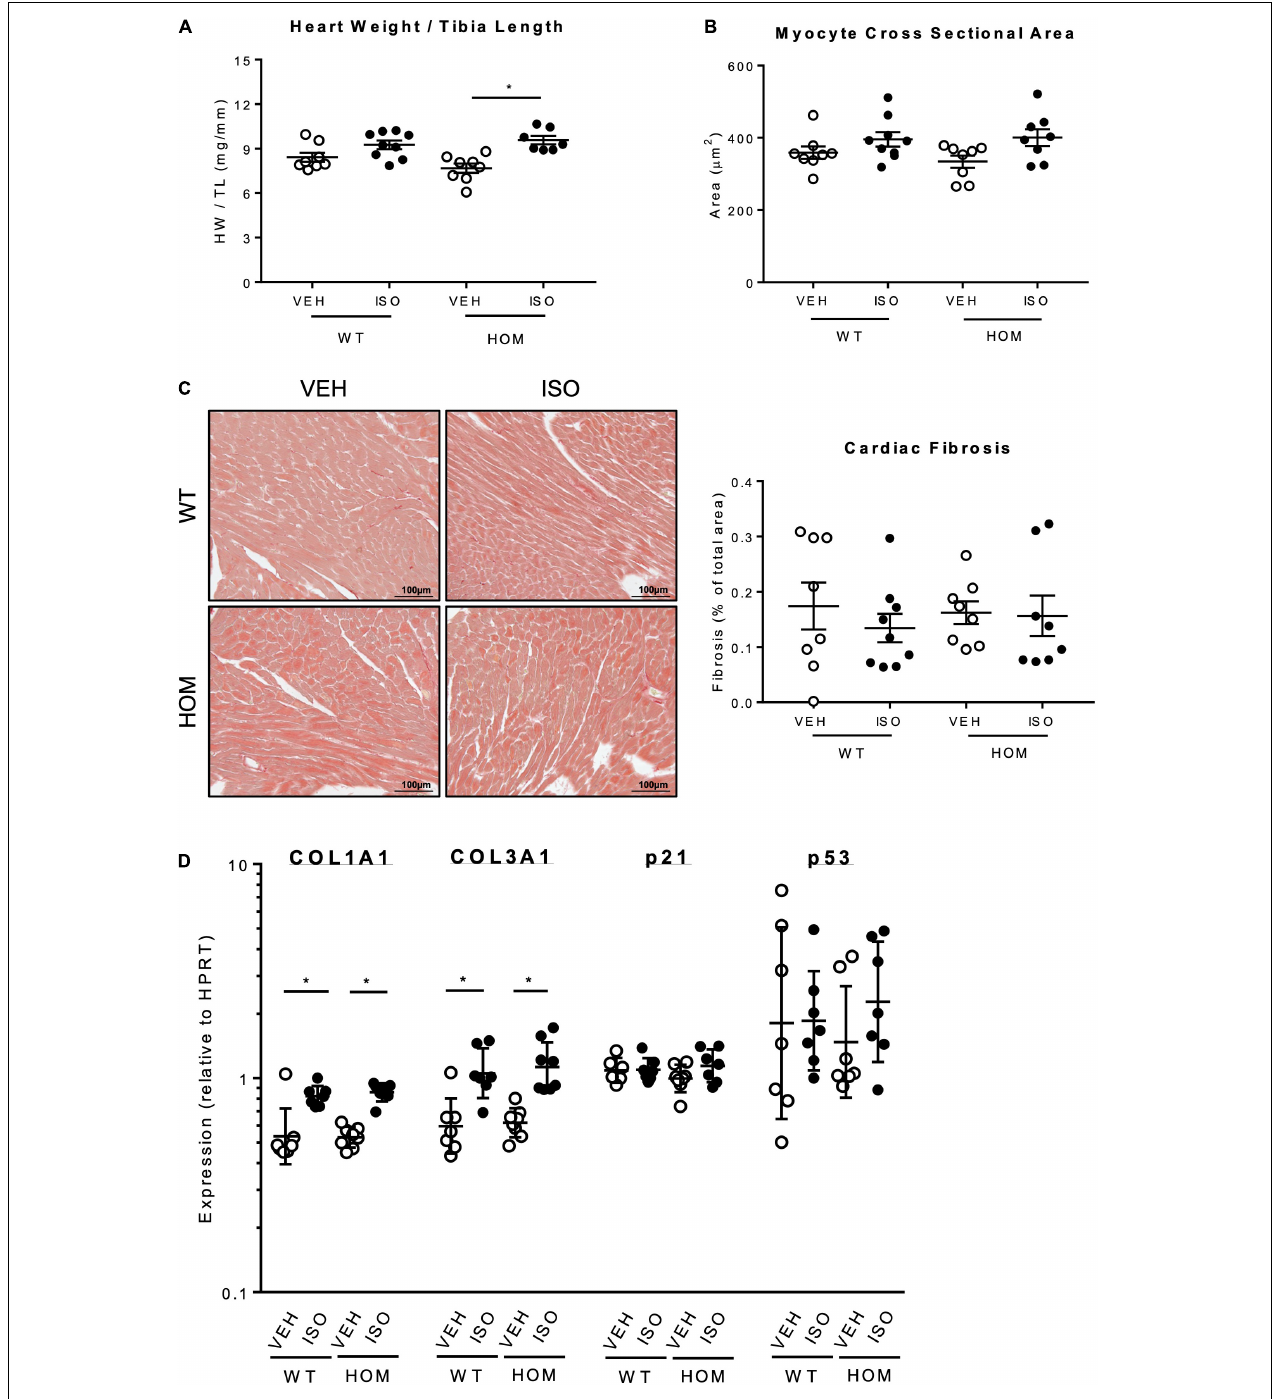
FIGURE 6 | Effects of sustained β -adrenergic stimulation on cardiac remodeling in male Tcap S157 / 161A KI mice. (A) Heart weight normalized to tibia length ( n = 7–9). (B) Analysis of cardiomyocyte cross-sectional area (CSA). Five micrometers formaldehyde-fixed paraffin-embedded mouse heart sections were stained with FITC-labeled wheat germ agglutinin (WGA) to identify the myocyte cell borders and myocyte CSA was measured by using NIH ImageJ software. (CSA was measured in ≥ 220 myocytes per group, n = 8–9.) (C) Representative images of Picro Sirius Red staining of paraffin-embedded mouse heart sections (left panel). Quantification of cardiac fibrosis determined by Picro Sirius Red staining (right panel) ( n = 8–9). Scale bars are 100 µ m. (D) Real-time qPCR analysis of mRNAs associated with fibrosis ( Col1a1 , Col3a1 ) and apoptosis ( p21 , p53 ) in cardiac tissue using the 2 − (cid:49)(cid:49) CT method ( Hprt used as a reference gene) ( n = 7–8). Heart weight to tibia length ratio, myocyte cross sectional area, and fibrosis quantification expressed as mean ± SEM, mRNA data expressed as geometric mean ± geometric SD, * p ≤ 0.05; two-way ANOVA with Tukey’s post hoc test.